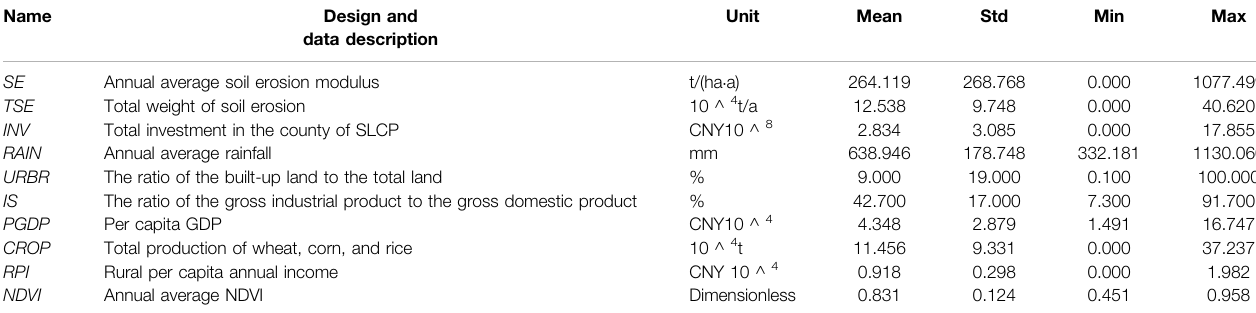
TABLE 3 | Variable design and descriptive statistics (in 2015).